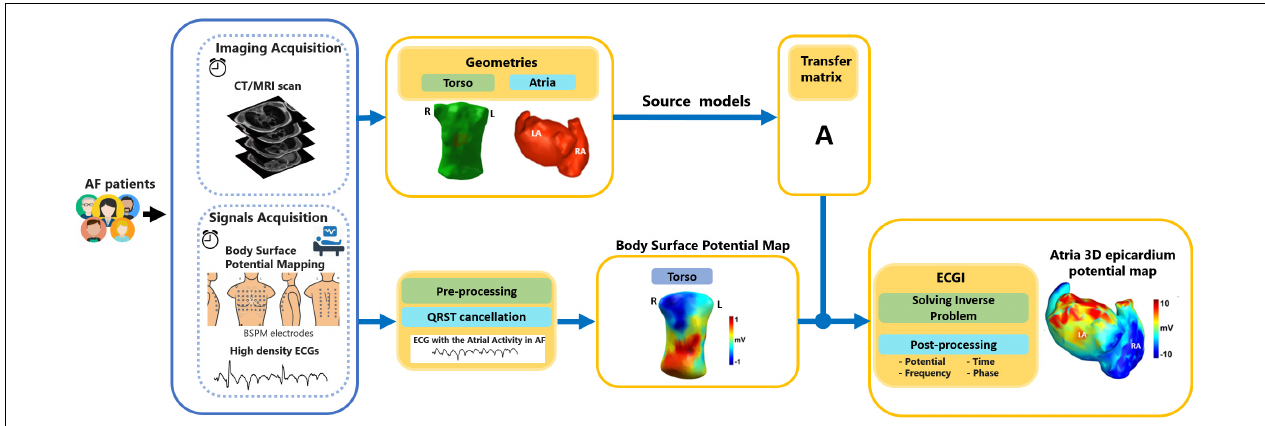
FIGURE 1 | Steps required for the estimation of the electrical potentials on the atrial epicardial surface by means of Electrocardiographic imaging (ECGI). Body-surface potentials are measured by means of a dense array of electrodes, and the torso and heart geometries are acquired through magnetic resonance imaging (MRI) or computerized tomography (CT). The atrial surface potentials are then reconstructed by adopting a specific source model (surface-potential model in the figure). Figure modified from Romero